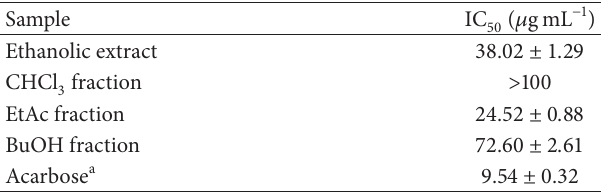
Table 1: Amylase inhibiting activity of C. officinalis extract and